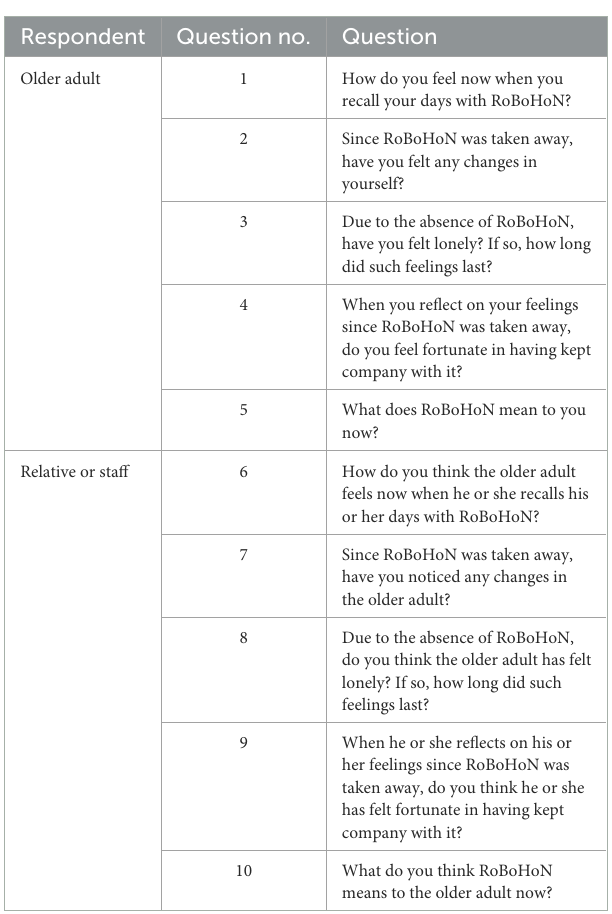
TABLE 4 Major questions in the